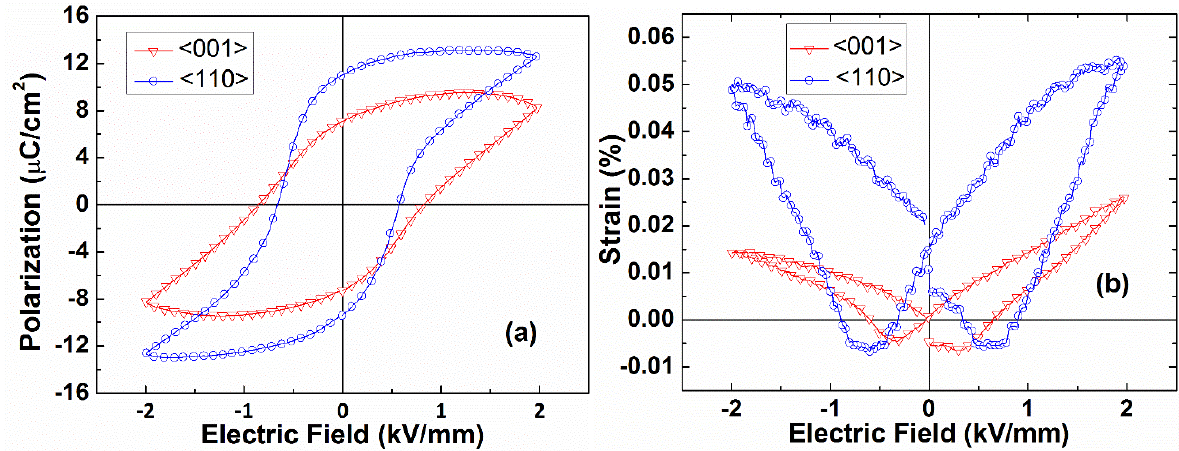
Figure 12. (Color online) ( a ) Polarization and ( b ) strain hysteresis loops of (100) pc and (110) pc oriented KNN25/75 single crystals at room temperature. Reprinted with permission from [28]. Copyright 2014 Royal Society of